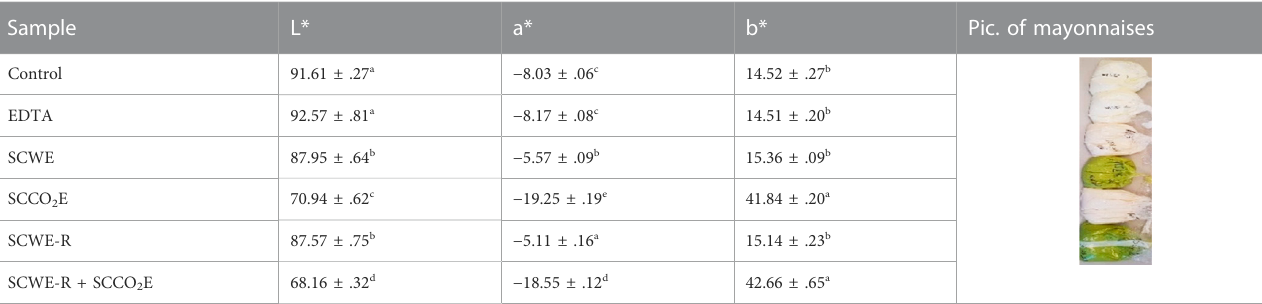
TABLE 4 The color values of mayonnaise with different antioxidants added (and control without antioxidant added) were measured at the beginning of the storage period (on day 1). L* for lightness, a* for green/redness, and b* blueness/yellowness.